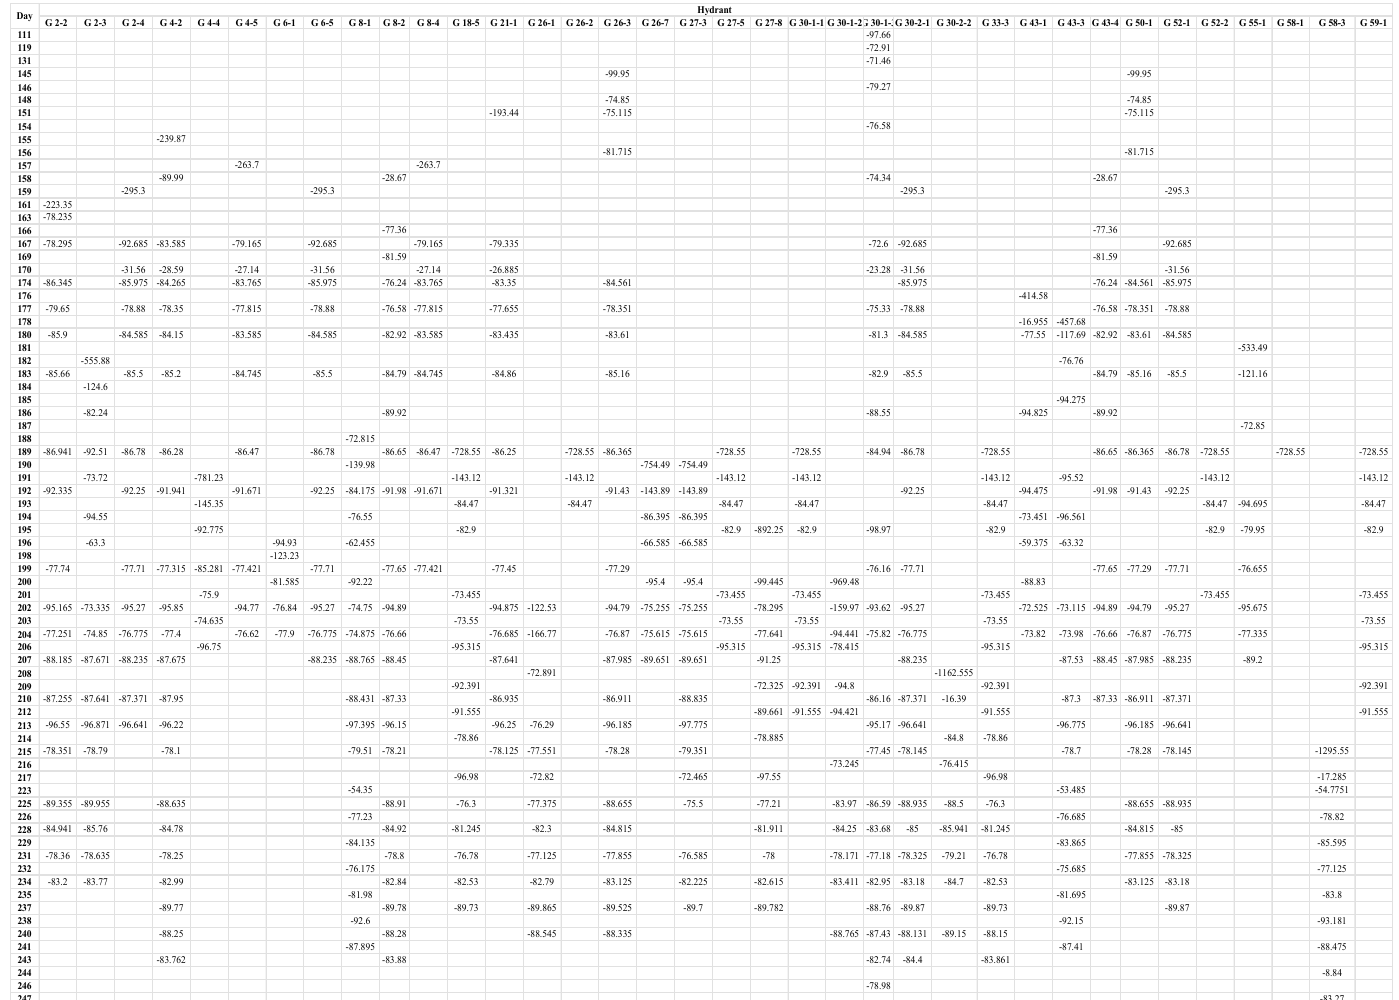
Table 3. List of hydrants to be opened day by day and volumes (m 3 ) to be supplied during the growing season for grape (year 2016).